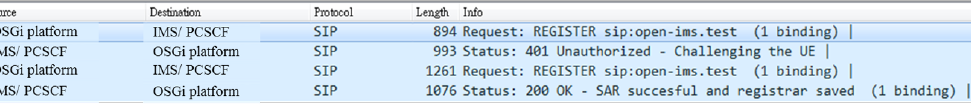
Figure 11. Registration for services on the IMS service proxy platform.